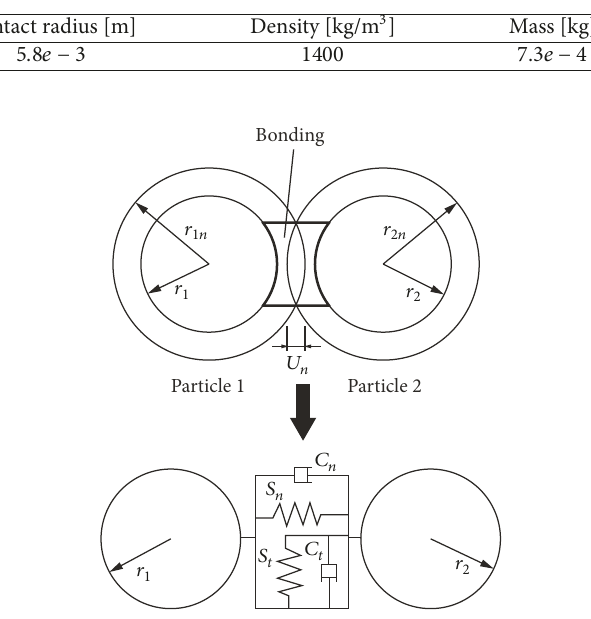
Table 3: Parameters of coal particles.